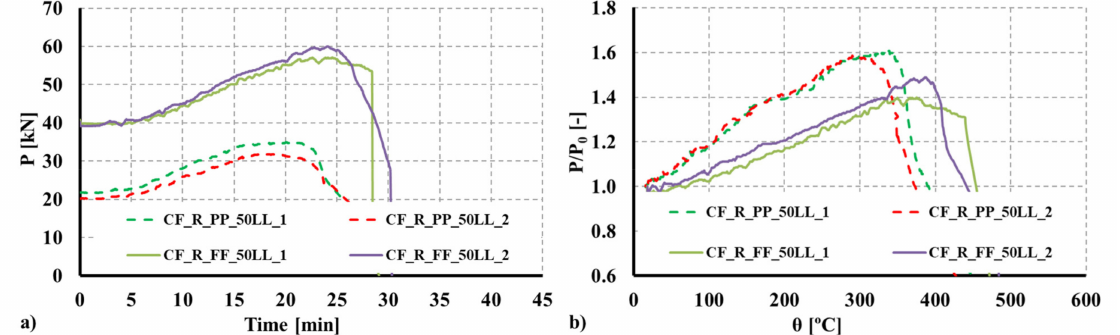
Figure 8. ( a ) Evolution of axial forces due to restraint to thermal elongation for the composite R section. ( b ) Evolution of the P/P 0 ratio for the composite R